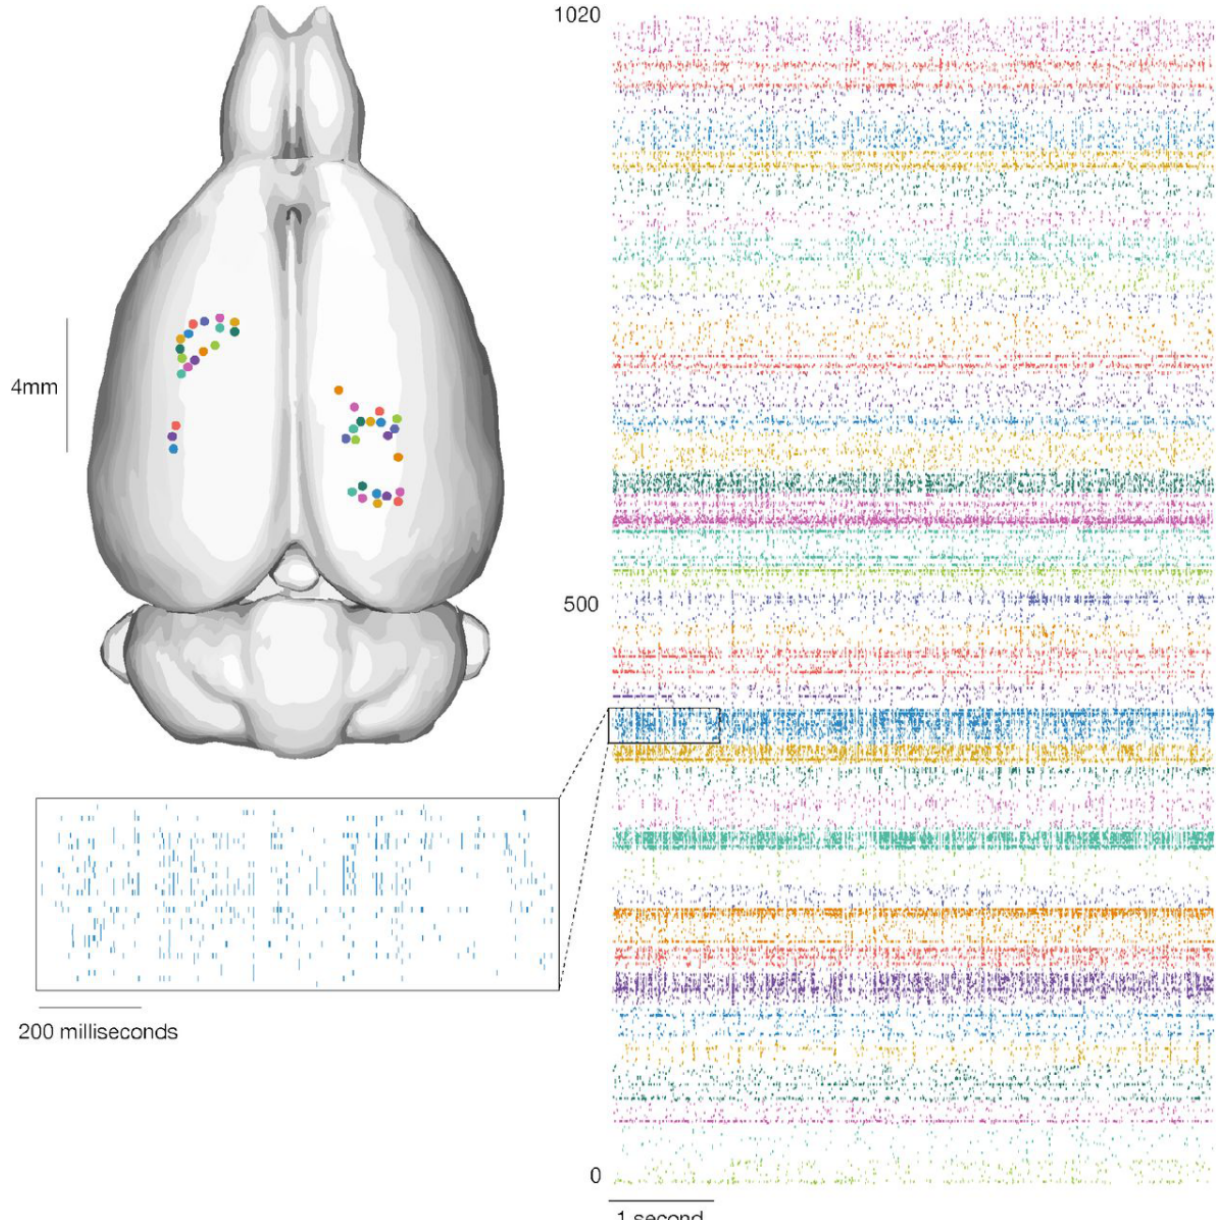
Figure 8. Our devices allow the recording of widespread neural activity distributed across multiple brain regions and cortical layers. Left: Thread insertion sites (colored circles) are indicated on the rendered rodent brain [38]. Right: Raster of 1020 simultaneously recorded channels, sorted per thread (color corresponds to insertion site). Inset: Enlarged raster of spikes from a single thread. This thread corresponds to the one shown in Figure